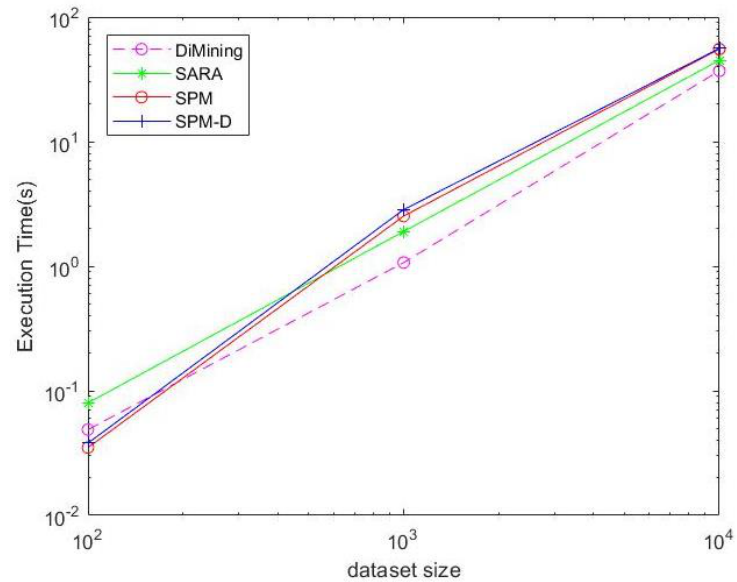
Figure 13. Comparison of efficiency of different algorithms.